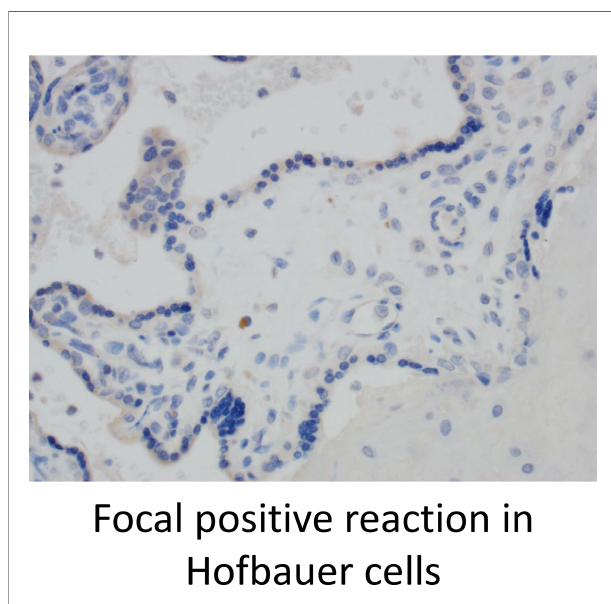
FIGURE 4 | CTLA4 is weakly expressed in the placenta but is found on a few Hofbauer cells. Representative CTLA4 staining in all three groups